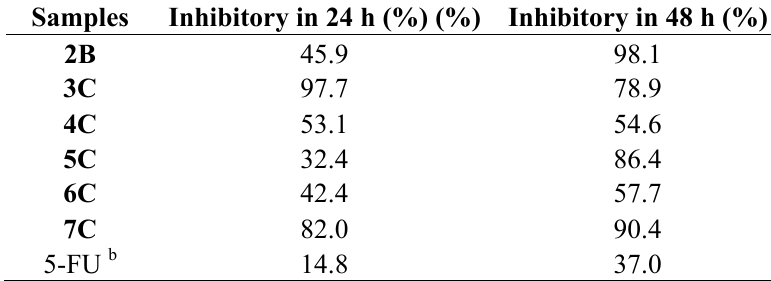
Table 5. Cytotoxic efffects of monoesters of M1 on MGC80-3 a .